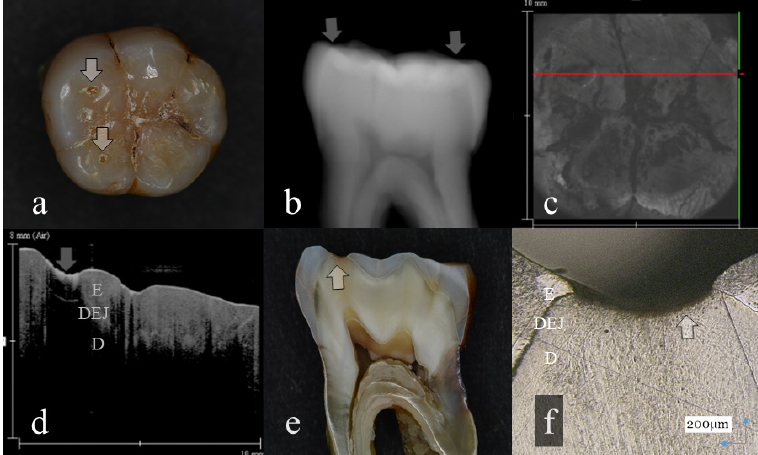
Figure 7. Tooth wear with distinct dentin exposure (score 4); ( a ): Occlusal view. Occlusal cusps were flattened and small dents were observed at the mesial cusps for both the buccal and lingual surface (arrow); ( b ): Digital intraoral radiography. Occlusal surface appeared flattened with the reduced remaining enamel thickness (arrow); ( c ): OCT en face intensity projection; ( d ): SS-OCT image. The tooth wear with distinct dentin exposure was clearly imaged (arrow). Brightness of exposed dentin subsurface was dramatically increased, suggesting the presence of dentin demineralization (arrow); ( e ): Histological view. At the dentin exposure site, the subsurface turned brown (arrow). Remaining enamel thickness of occlusal surface was reduced; ( f ): CLSM image of histological view. Dentin exposure with dentin demineralization was observed at the tooth wear surface (arrow). The corresponding dynamic slicing 3D video is in Supplementary Materials: Video S4. The upper right is a cross sectional view. The image on the lower right is an en face view. Table 1. Sensitivity (score 2, score 3, and score 4), specificity, and AUC values, obtained from SS-OCT. Investigator